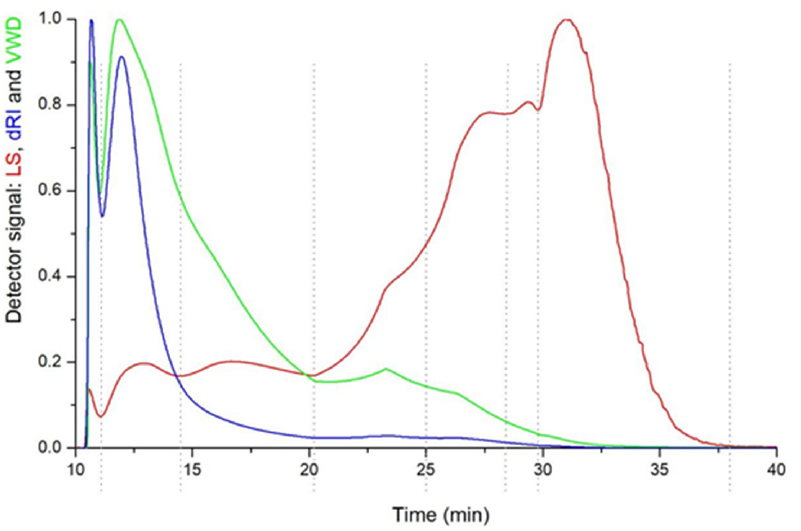
Figure 4. Representative elution profile of dark beer together with the peak settings. Detector signals: red—light scattering at 90°, green—absorbance at 280 nm, and blue—differential refractive index. Table 5. Results of analysis of dark beer (50 µL original and 100 µL 1:1 diluted sample measured each in triplicate). Values are given as average and standard deviation of all measurements ( n = 6). Note that different peak settings have been applied compared to the values given in Table 4. n.d. =